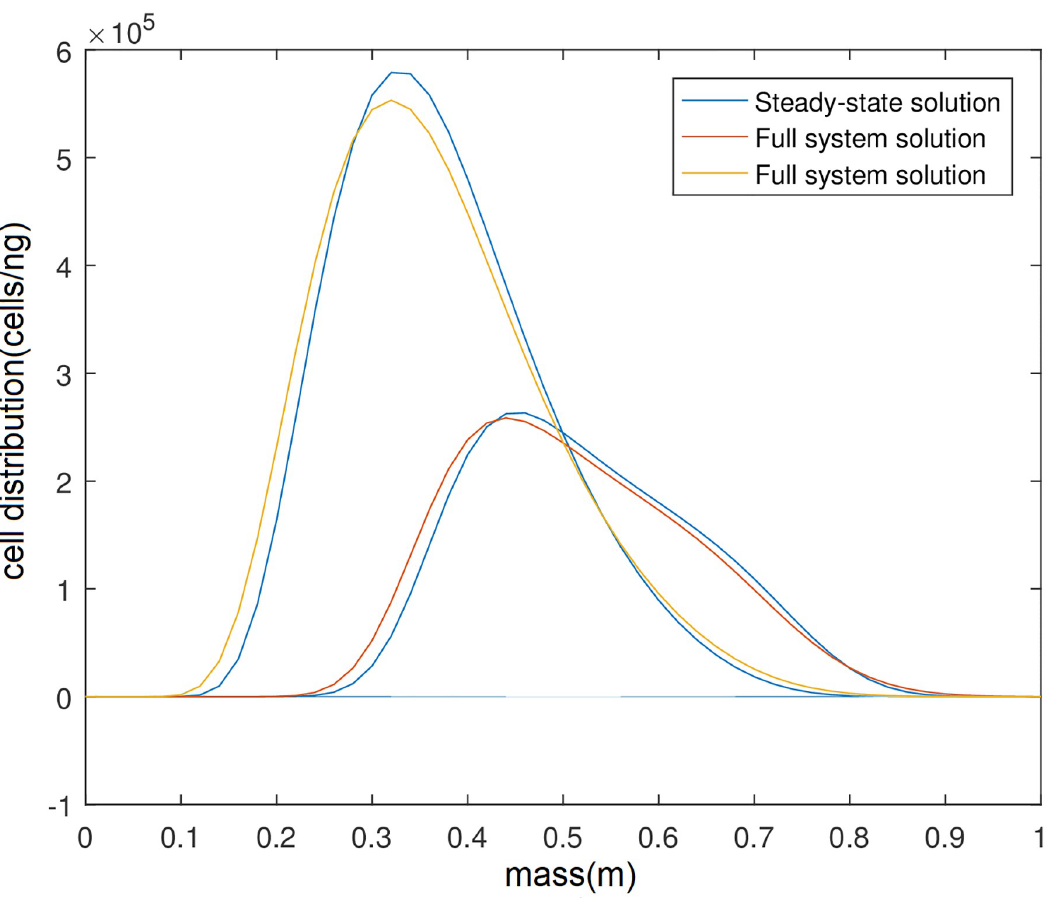
Fig 5. Steady state distribution of competing populations x and y from numerical solution of the steady-state form of Eqs (1)– (3) (zero time derivative) in yellow and red respectively and from the numerical solution of the full system of Eqs (1)–(3) in blue. For all simulations we assume that there is no delay between change detection and